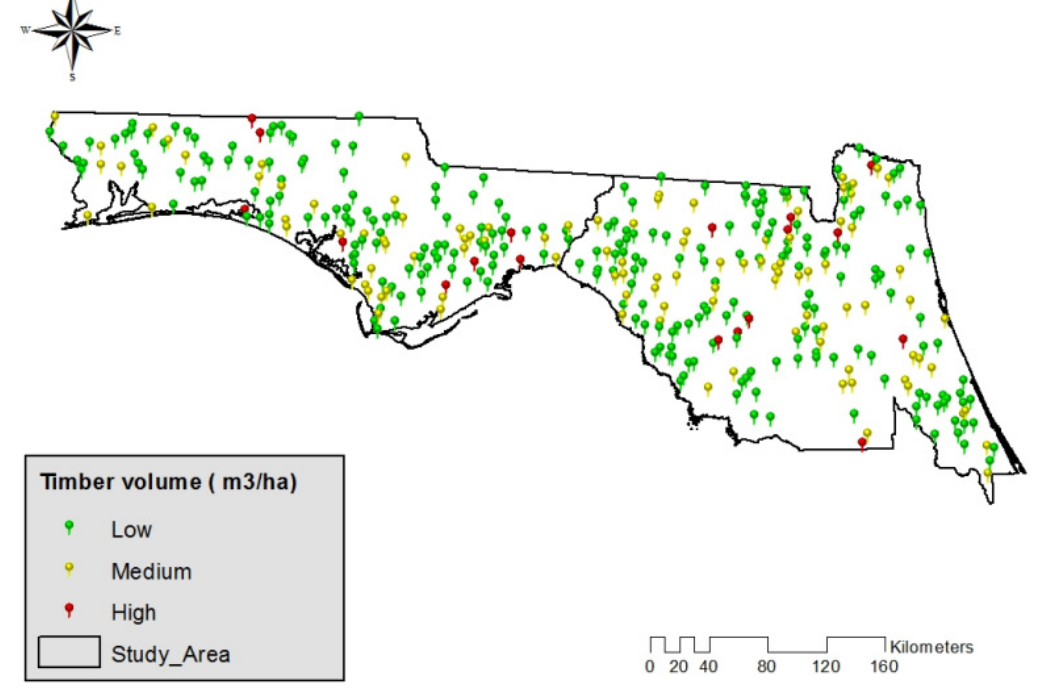
Figure 5. Timber volume provision levels for Forest Inventory Analysis (FIA) Pinus elliotti plots in Florida’s northeastern and northwestern survey units,